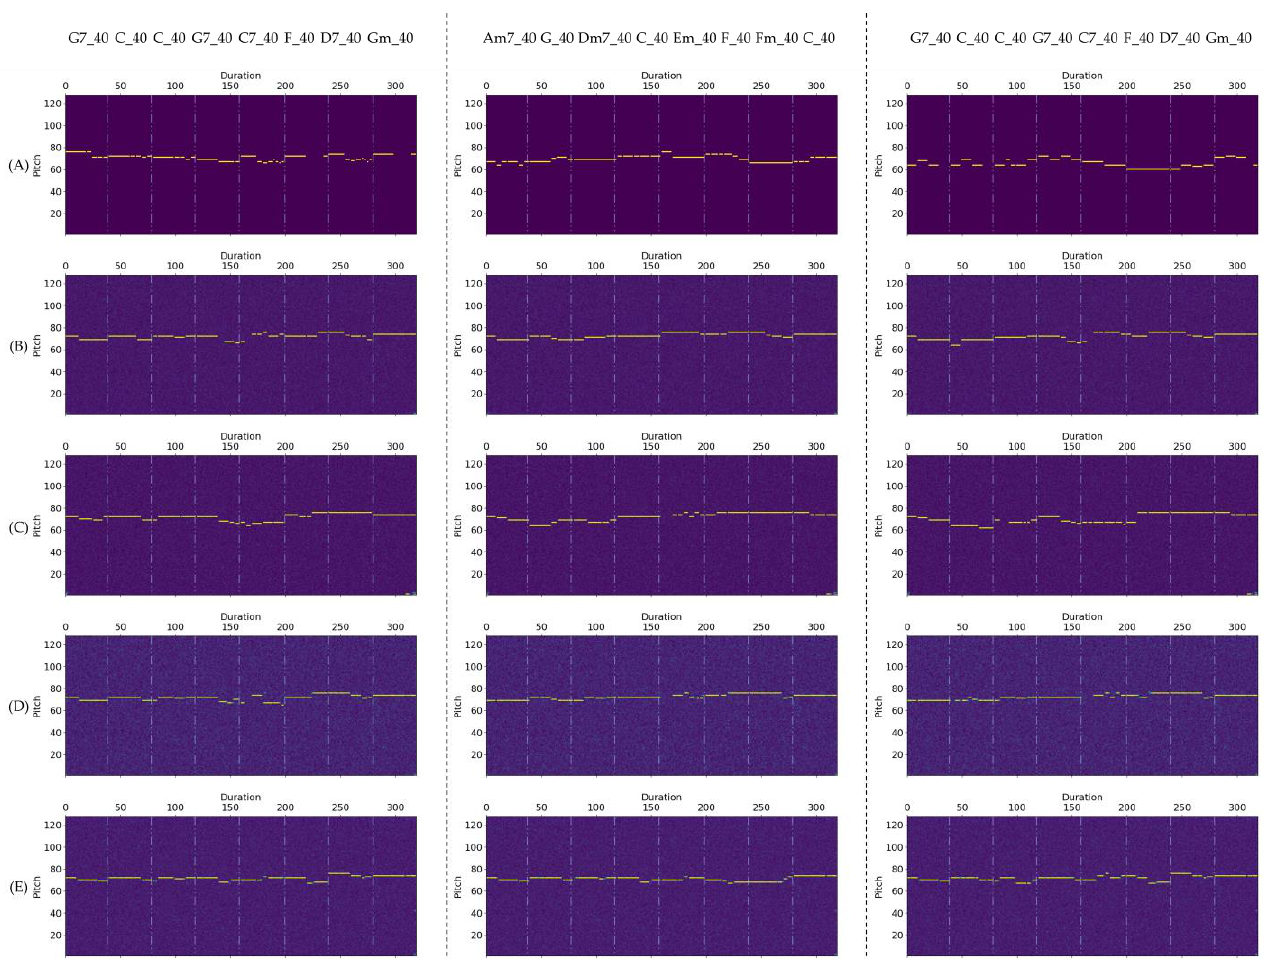
Figure 7. Visual comparison of the Softmax probability distribution of original and generated mel- odies. ( A ) Original melodies; ( B ) generated melodies based on the base version of MelodyDiffusion; ( C ) generated melodies based on the large version of MelodyDiffusion; ( D ) generated melodies based on the stable diffusion model; ( E ) generated melodies based on the w/o encoder